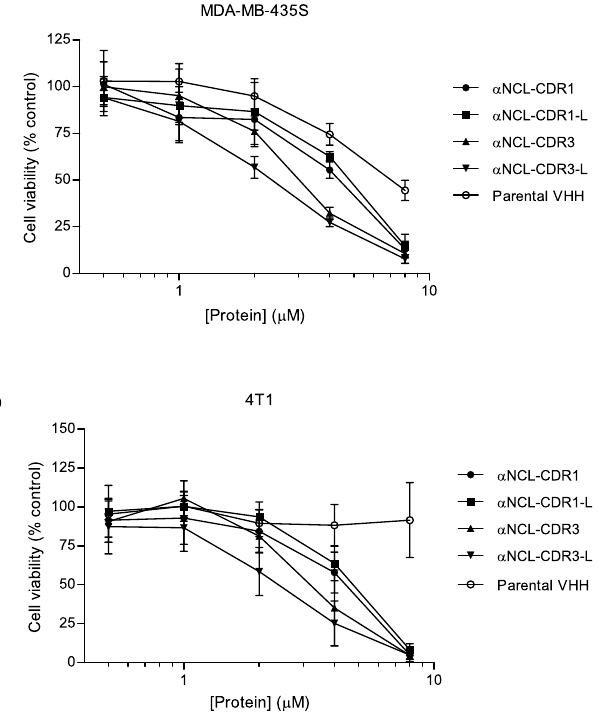
Figure 3. Cytotoxicity of anti-nucleolin VHHs against nucleolin-overexpressing cancer cells. Different VHH constructs, grafted with a nucleolin-binding peptide sequence either onto CDR1 or CDR3, with ( α NCL- CDR1-L or α NCL-CDR3-L, respectively) or without ( α NCL-CDR1 or α NCL-CDR3, respectively) flanking linkers at the end of the grafted CDR, were incubated with ( a ) MDA-MB-435S or ( b ) 4T1 cancer cells, at concentrations up to 8 µ M, for 72 h at 37 °C. The parental VHH, without the targeting component to nucleolin, was included as control. In the end of the incubation, cytotoxicity was assessed by the MTT assay. Data represent the mean ± SD of at least three independent experiments, performed in duplicate. Differences in cytotoxicity among the tested VHHs were evaluated by one-way ANOVA followed by Tukey’s test ( * p < 0.05, ** p < 0.01, *** p <